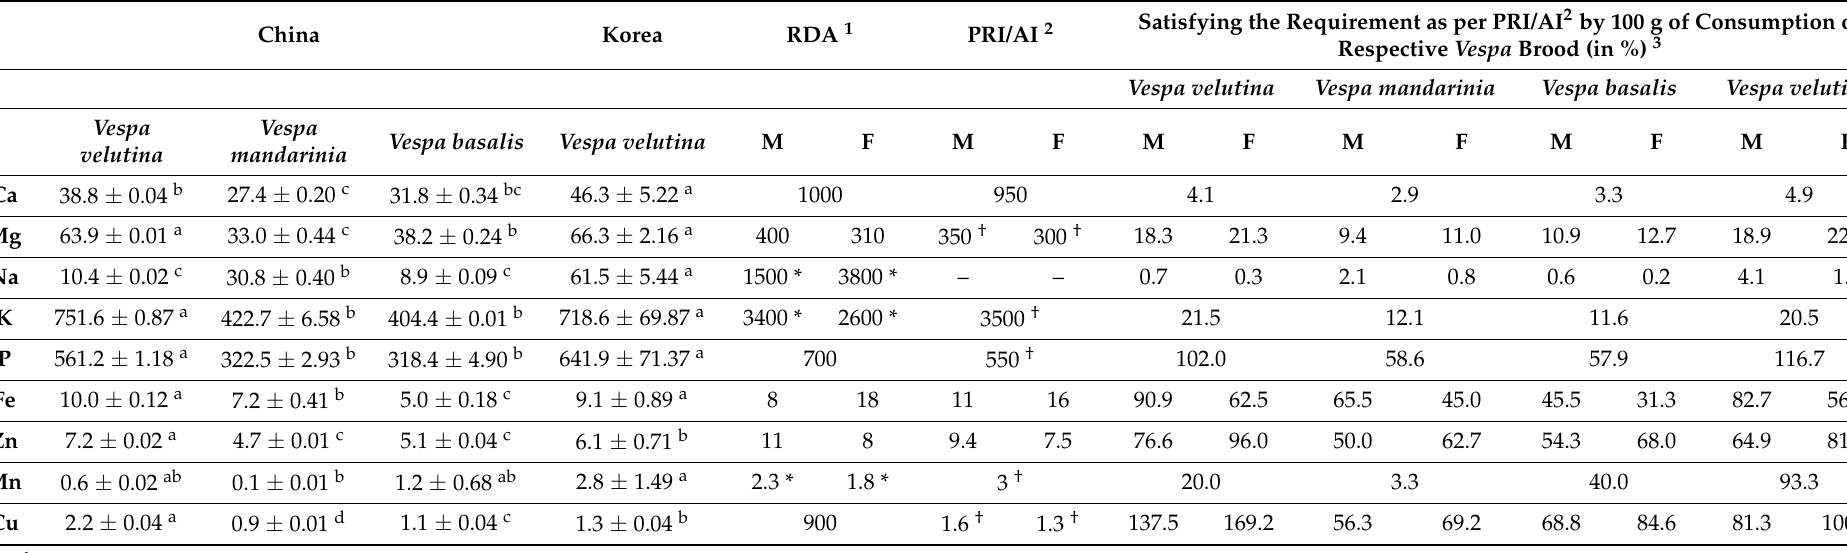
Table 3. Mineral contents (mg/100 g dry matter, mean ± SD, duplicate analysis with composite sampling process) of different Vespa species broods and recommended dietary allowance (RDA) or population reference intakes (PRI) and satisfying the requirement in % Satisfying the Requirement as per PRI/AI 2 by 100 g of Consumption China PRI/AI 2